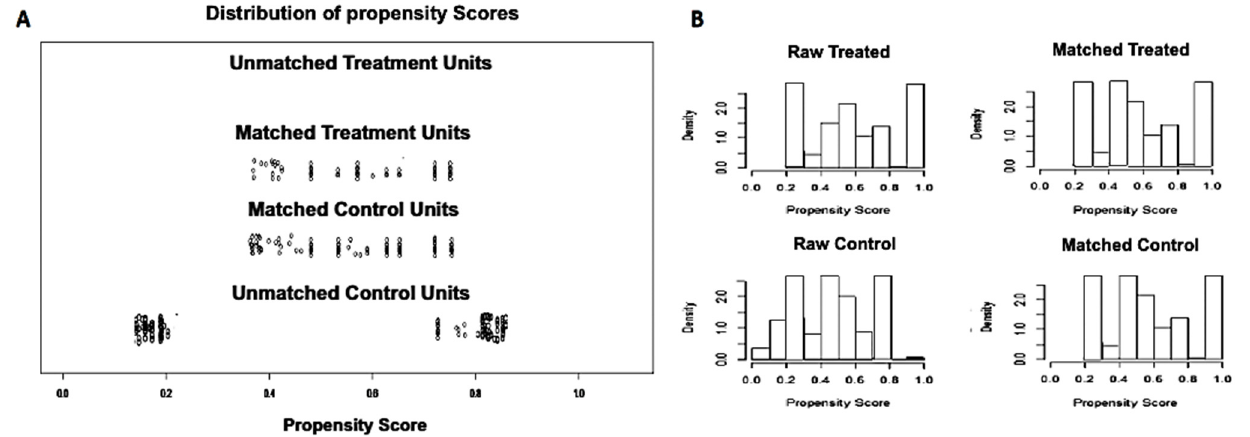
Figure 2. Propensity score matching. Out of 236 patients with pancreatic cystic lesions, after propensity score matching two groups were compared: 98 subjects who underwent through-the-needle biopsy under antibiotic prophylaxis and 49 sampled without prophylaxis. ( A ). Propensity score matching jitter plot. ( B ). Propensity score matching histogram.